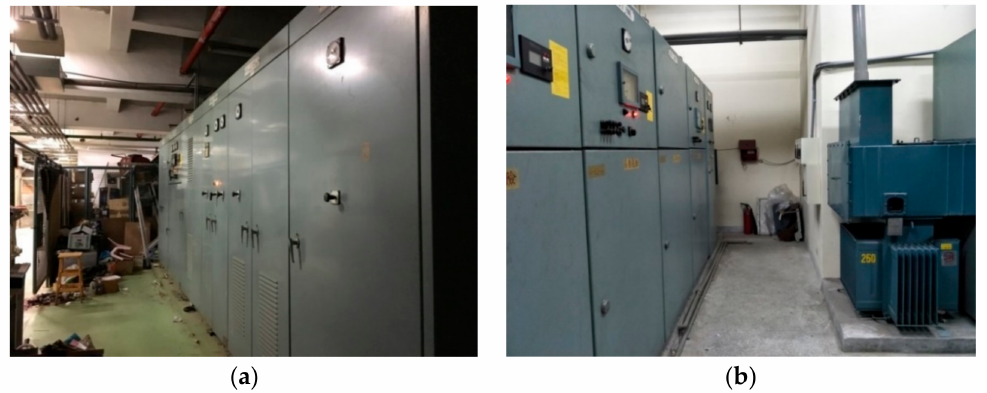
Figure 17. Original power substation in Taiwan Tech: ( a ) library; ( b ) T3 building.